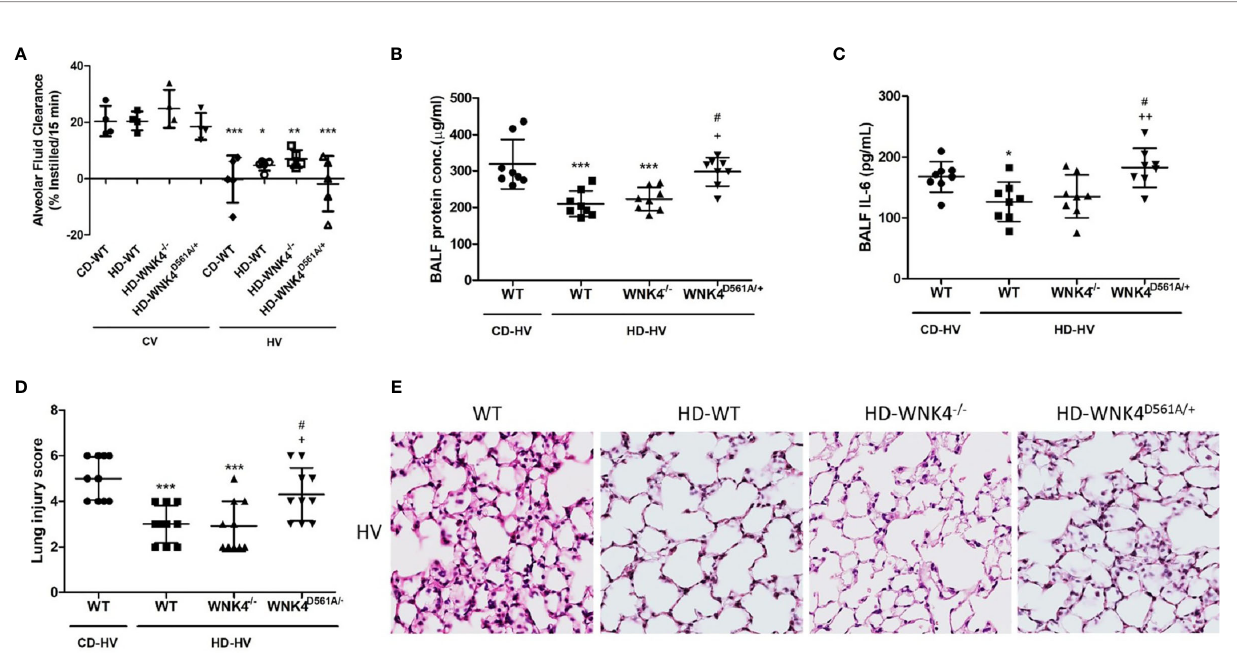
FIGURE 7 | The effect of obesity and WNK4 manipulation on alveolar fl uid clearance (AFC) and ventilator-induced lung injury after 6 h of mechanical ventilation (HV). These parameters were collected in nonobese wild-type mice (CD-WT), obese wild-type mice (HD-WT), obese mice with WNK4 knockout (HD-WNK4 − / − ), and obese mice with WNK4 knockin (HD-WNK4 D561A/+ ). (A) AFC. * P < 0.05, ** P < 0.01, and *** P < 0.001 compared with the corresponding group in the CV condition. (B) BALF protein concentration. (C) BALF IL-6. (D) Lung injury score. (E) Hematoxylin and eosin staining of pathological specimens (magni fi cation, 400×). CV, 6 h of spontaneous breathing. BALF, bronchoalveolar lavage fl uid. Data are expressed as the mean ± SD (n = 10 per group, with the exception of n = 3 – 5 in the AFC experiment). * P < 0.05 and *** P < 0.001 compared with nonobese wild-type mice (CD-WT), AFC experiment excluded. + P < 0.05 and ++ P < 0.01 compared with the obese wild type mice group (HD-WT). # P < 0.05 compared with the obese mice with WNK4 knockout (HD-WNK4 − / −